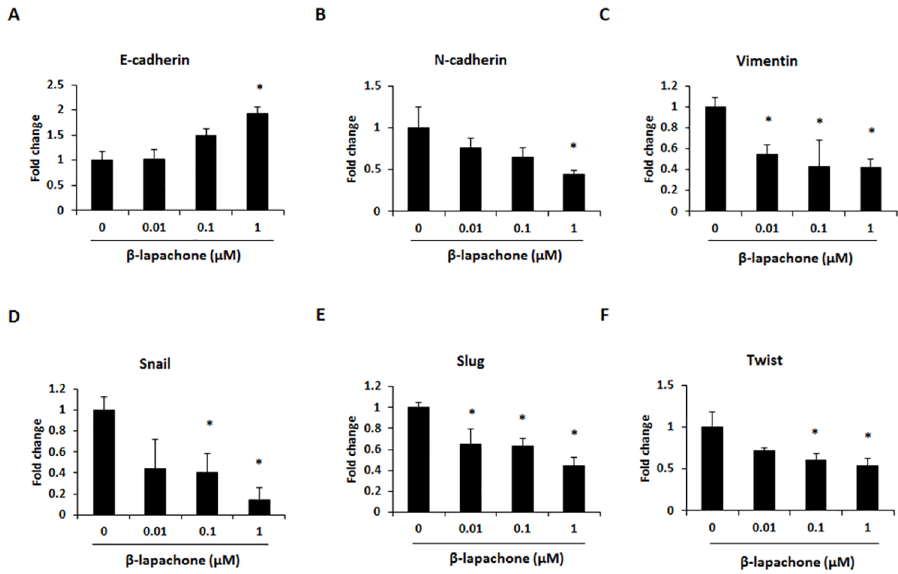
Fig 7. Effect of β -lapachone on the EMT markerexpression in B16F10 cells. The mRNA expression levels of EMT-related genes were measured by real-time RT-PCR in β -lapachone-treated cells. B16F10 cells were treated with β -lapachone(0.01–1 μ M) for 24 h. Values are the means ± SD of data from three independent experiments. * P < 0.05.